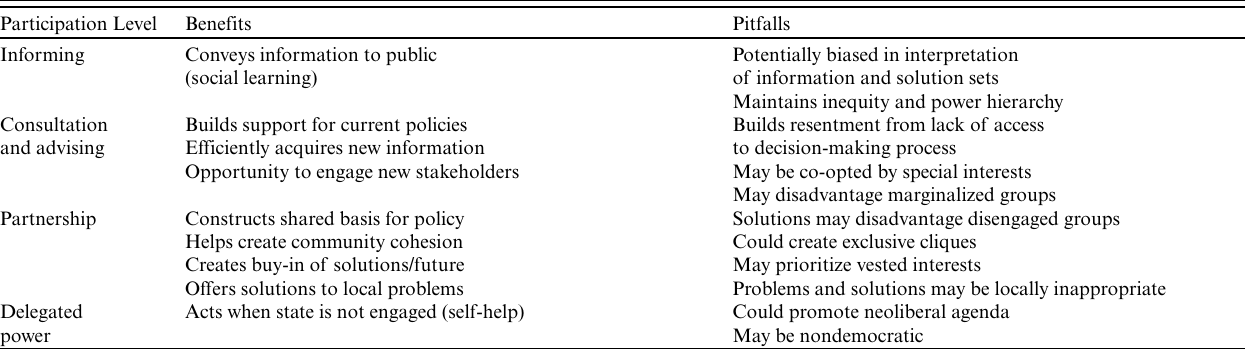
Table 2 . Benefits and pitfalls of different levels of public participation and their contextual